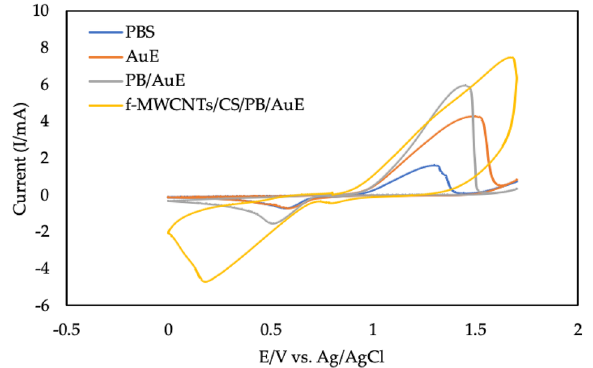
Figure 3. Cyclic voltammogram of electrode configurations in the presence of Zn 2+ . Experimental conditions were (0.1 M, pH 2) PBS under 250 mVs -1 of scan rate for 5 s accumulation time. PBS was control of the experiment in absence of Zn 2+ .